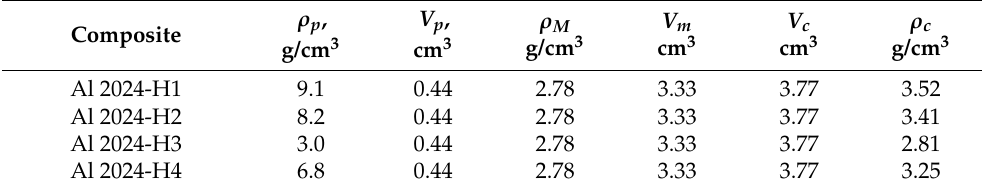
Table 4. Fabricated surface nanocomposites’